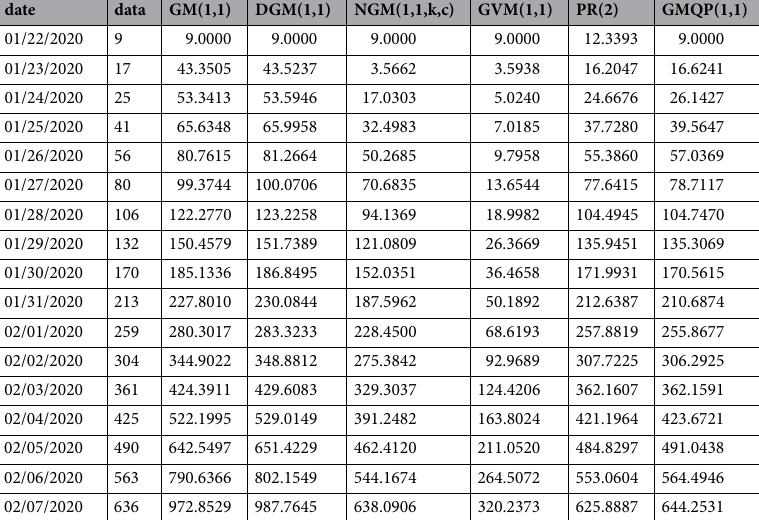
Table 12. The computational results of the death cases of COVID-19 of China.